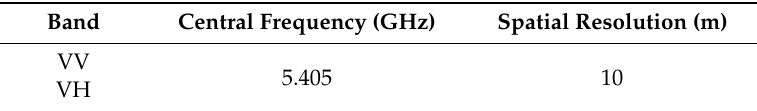
Table 1. The central frequency and spatial resolution for Sentinel-1 bands used in this study. VV represents vertical transmitting with vertical receiving and VH represents vertical transmitting with horizontal receiving. Band Central frequency (GHz) Spatial resolution (m) VV 5.405 10 VH